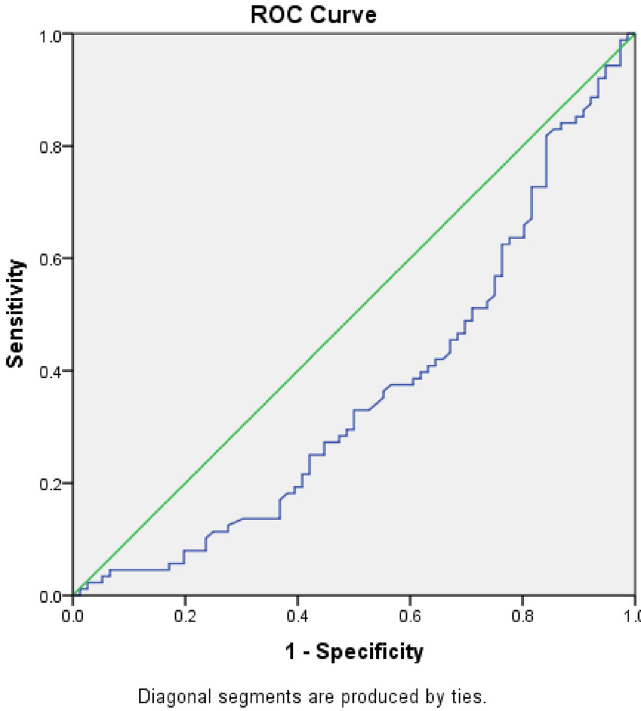
Figure 1. ROC analysis for determination of P4 on OR day effect on achieving